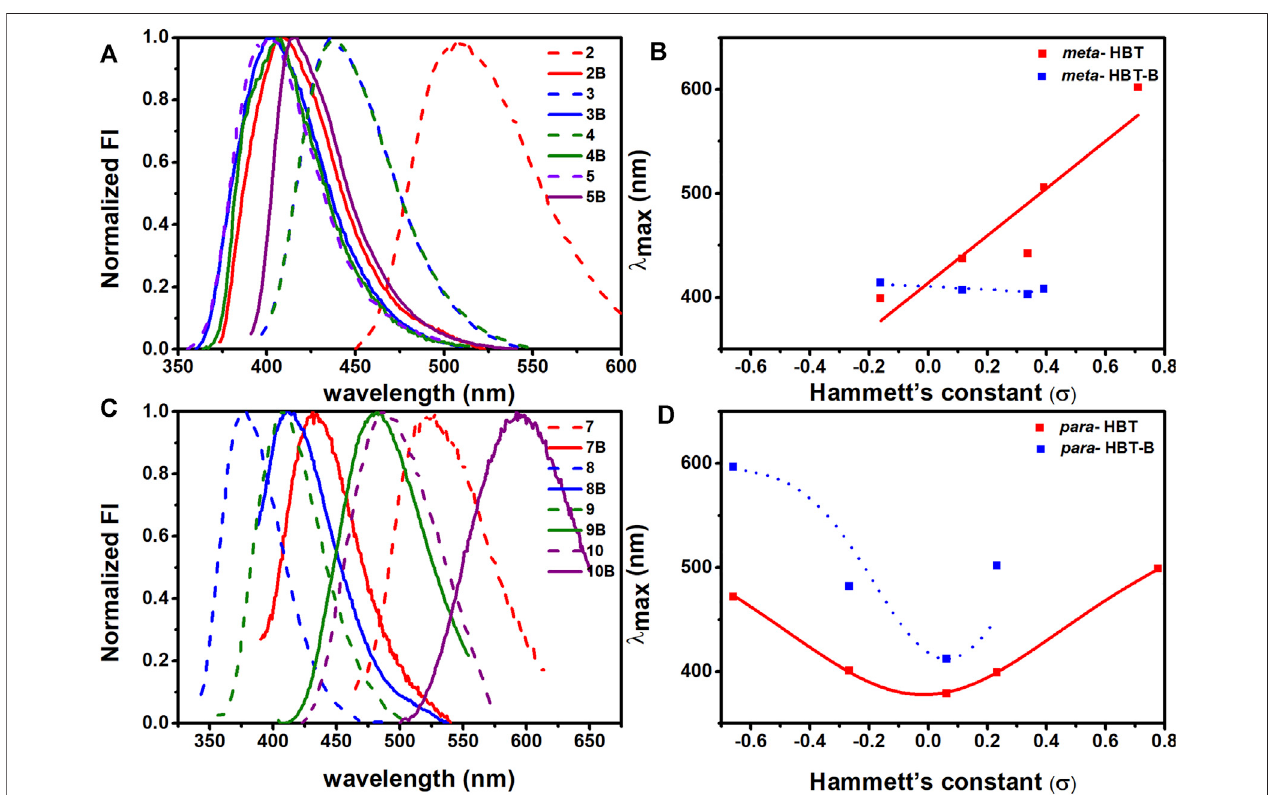
FIGURE2| Emissionspectraof 2-10 , 2B-10B inCH 3 CN. (A) Normalizedemissionspectraof 2-5 , 2B-5B inCH 3 CN; (B) Plotofthemaximumemissionwavelength of 2-5 , 2B-5B against the Hammet ’ s constant of the R substituent. (C) Normalized emission spectra of 7-10 , 7B-10B in CH 3 CN; (D) Plot of the maximum emission wavelength of 7-10 , 7B-10B against the Hammett ’ s constant of the R substituent.